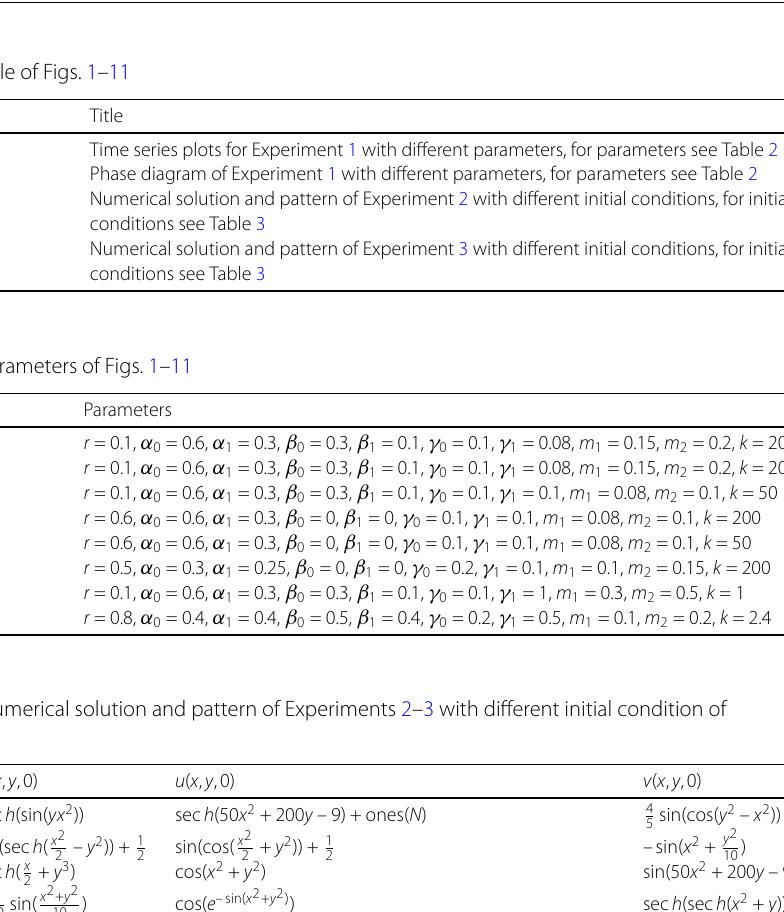
) 2 + ( y – 2 ) 2 )) sin( π (– x 2 + y 2 )) 5 5